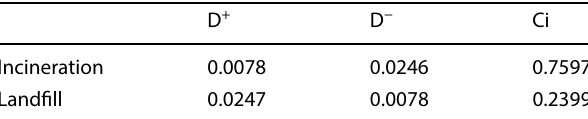
Table 10 Distance value and relative proximity value of measures in each scheme D + D −